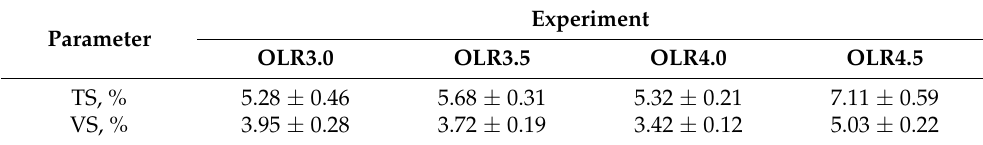
Table 4. Digestate TS and VS